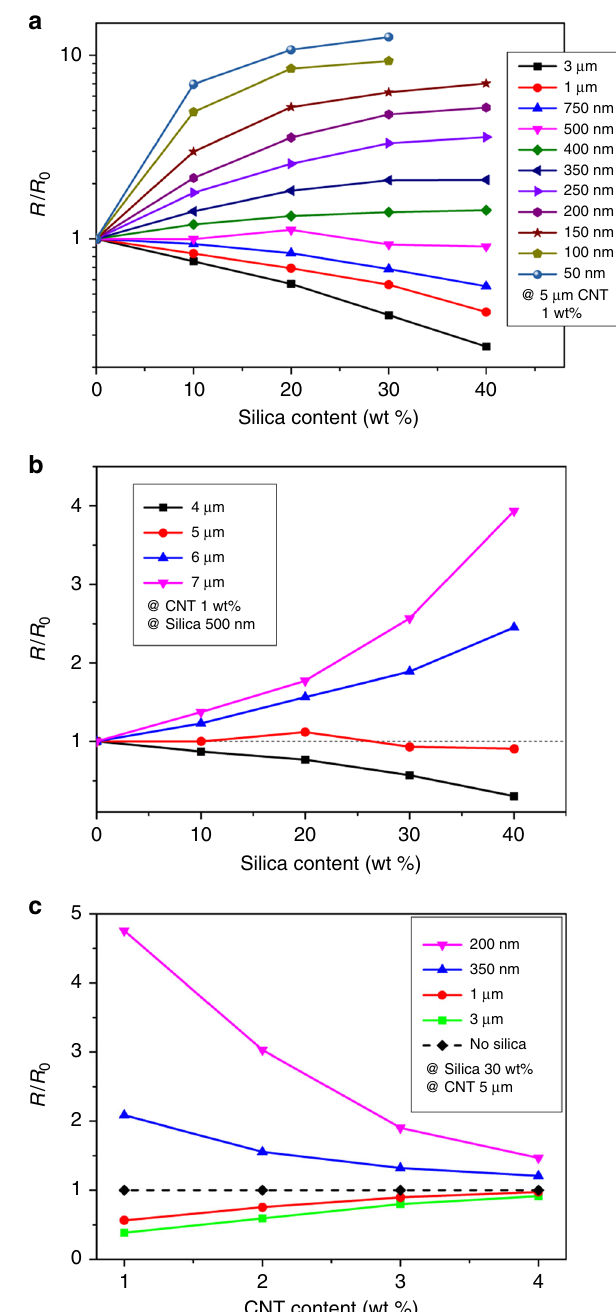
Fig. 6 Variation of resistivity measured by simulation. a Simulated normalized resistance ( R / R 0 ) as a function of silica wt% for different silica size. b R / R 0 as a function of silica wt% for different CNT lengths. c R / R 0 as a function of CNT wt% for different silica size with the CNT length and silica content fi xed. Horizontal line indicates CNT composite without silica particle